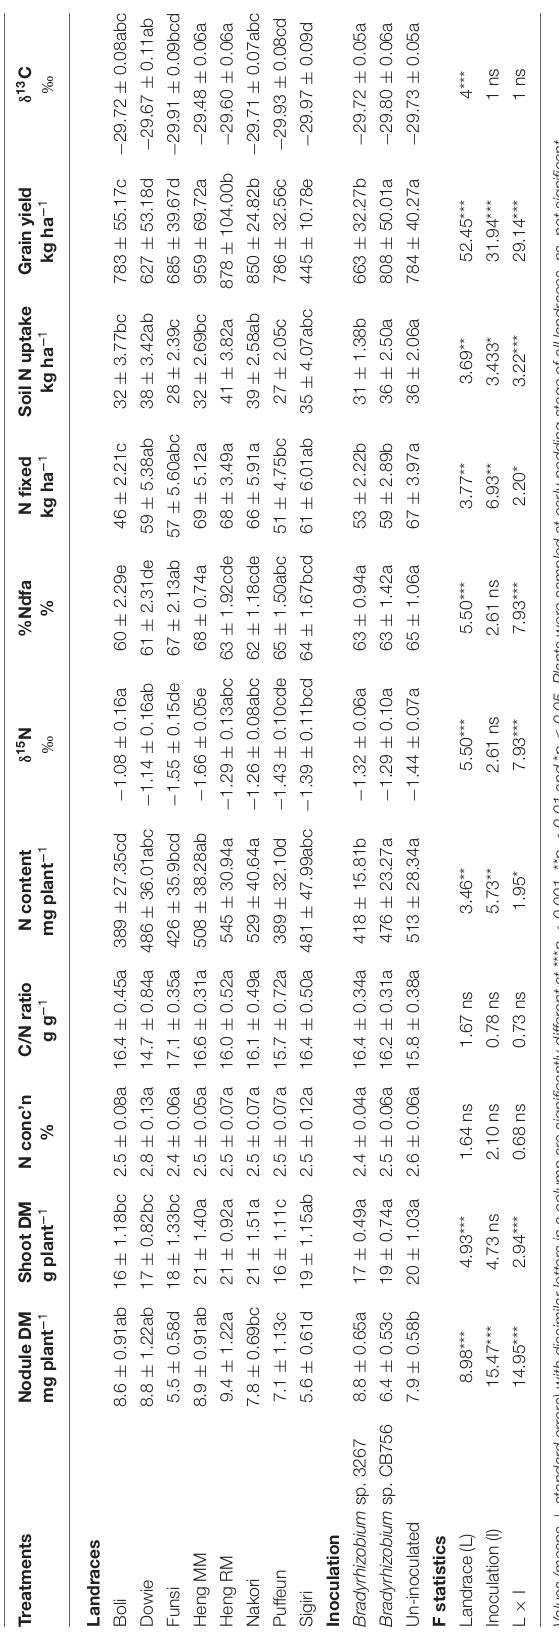
( Table 1 ). As observed with shoot N content, the average soil N uptake and grain yield of the plants at Nyankpala were higher in uninoculated plots or plots inoculated with strain CB756 relative to inoculation with strain 3267 at the site ( Table 1 ). However, there was no overall effect of inoculation on shoot δ 13 C at Nyankpala. Main Effect of Landrace on the Concentrations of Xylem N